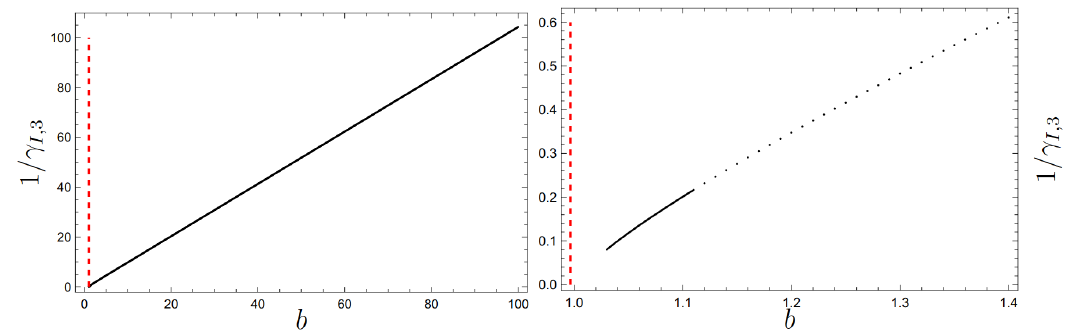
Figure 11 . Thermal conformal order parameter γ 3 ≡ T − 3 hO 3 i of the deformed Model III diverges as b → b + 0 , represented by the dashed vertical red crit ,III